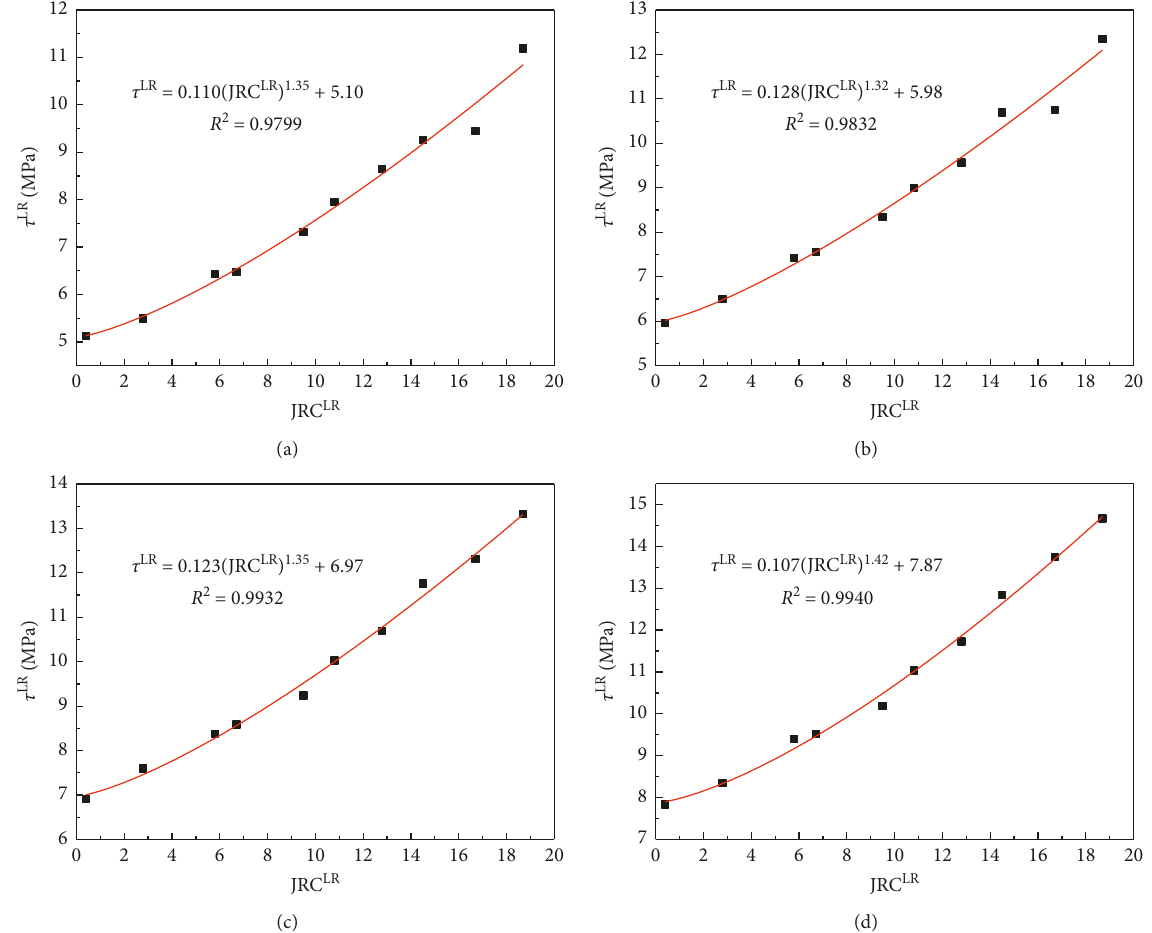
Figure 14: The fitting relationships between JRC LR and τ LR . (a) σ